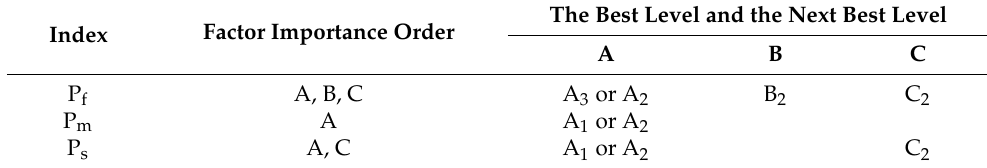
Table 8. Summary of results of pressed vines.